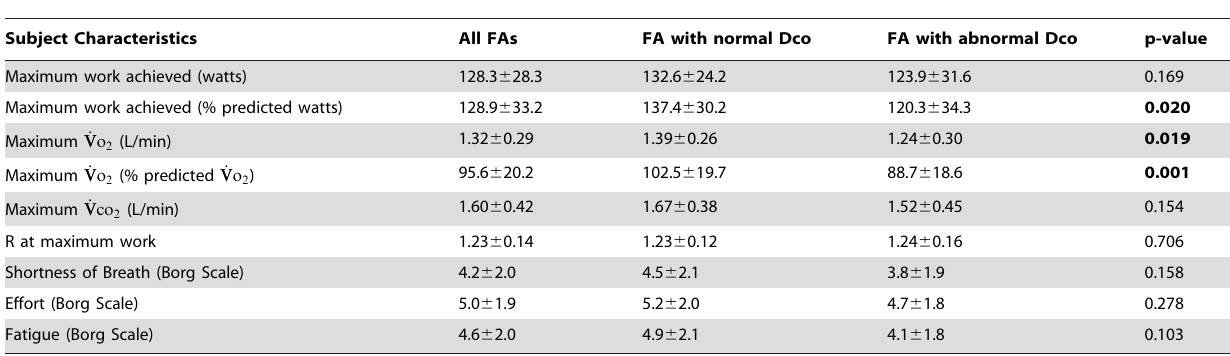
Table 2. Exercise